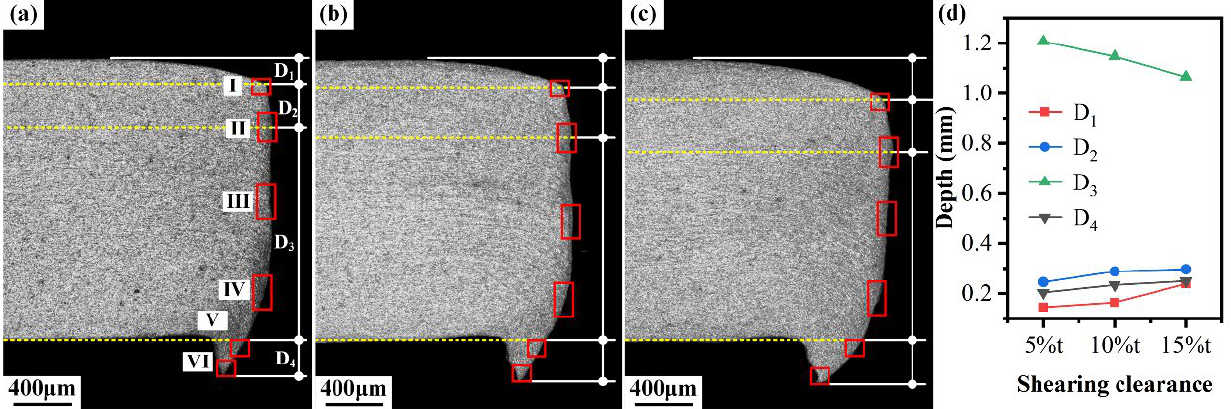
Figure 8. Morphology of sheared edge obtained under different shearing clearances and depths of typical zones: ( a ) 5%t ; ( b ) 10%t ; ( c ) 15%t . ( d ) Depths of rollover zone, burnish zone, fracture zone and burr zone. typical zones: ( a ) 5%t; ( b ) 10%t; ( c ) 15%t. ( d ) Depths of rollover zone, burnish zone, fracture zone and burr